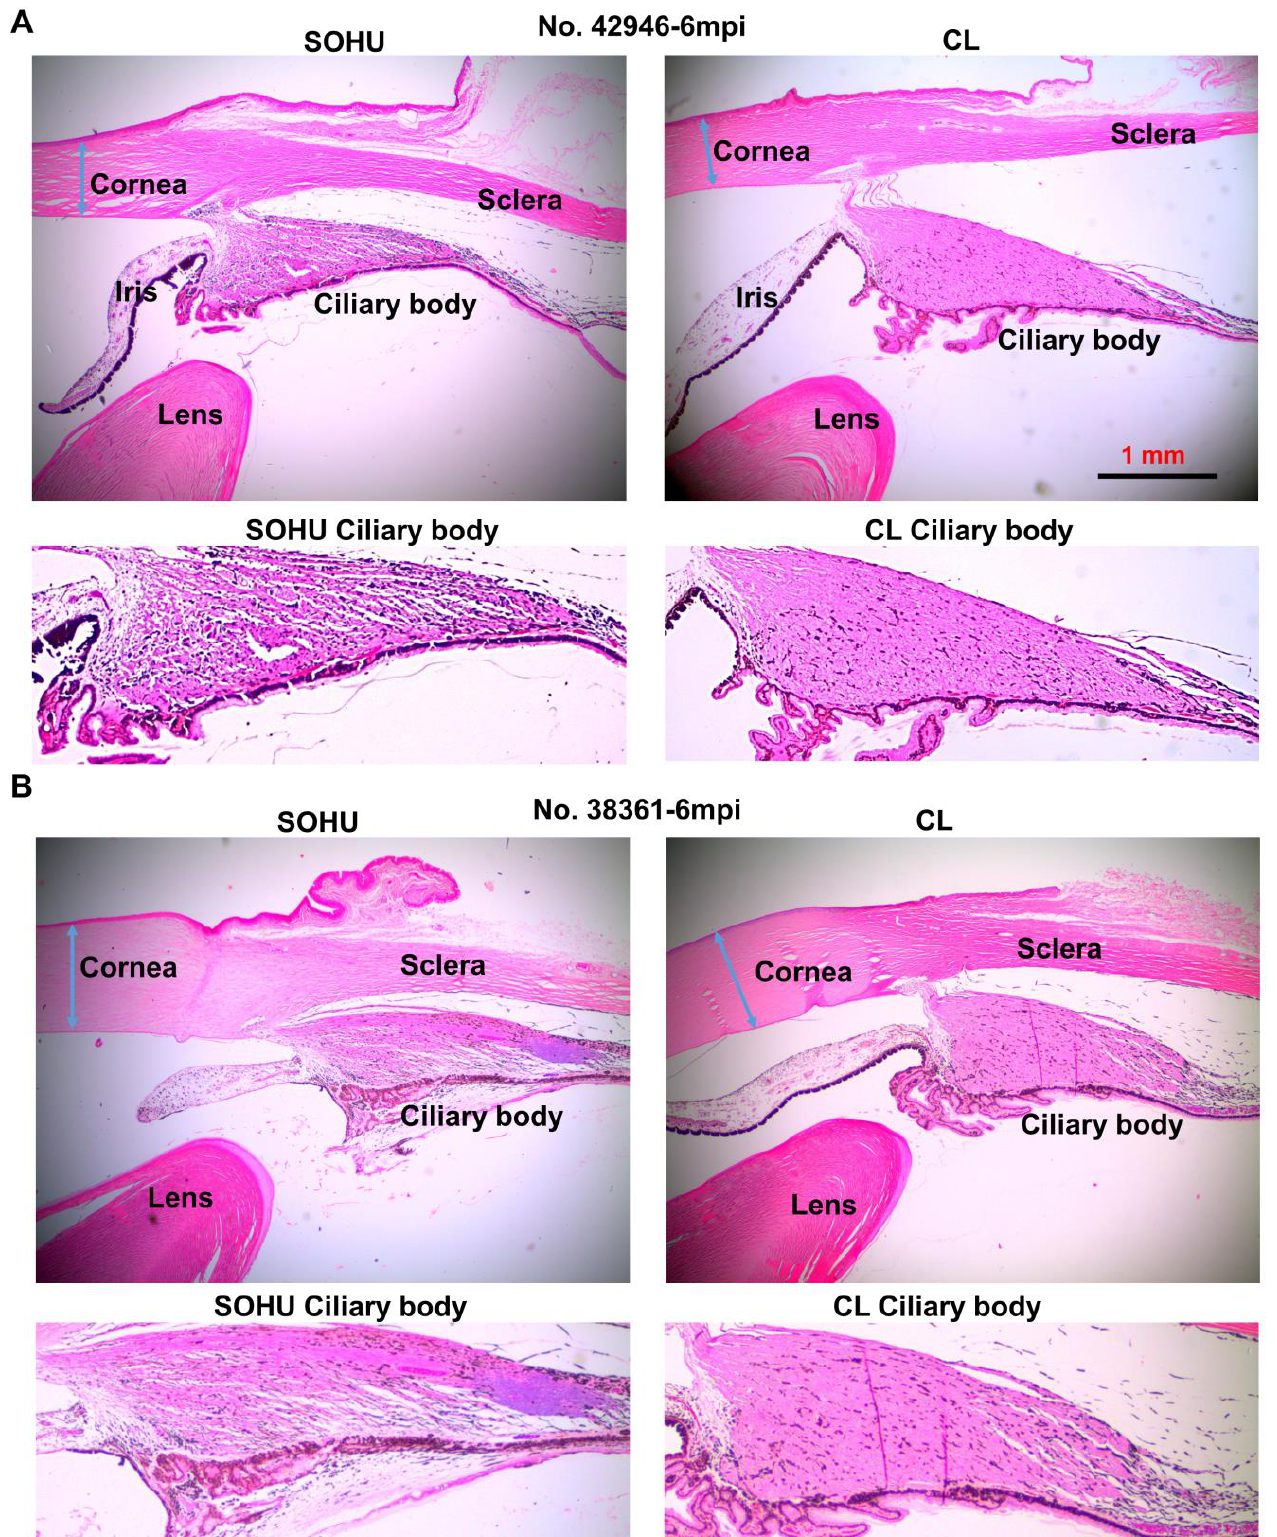
Figure 5. Ciliary body atrophy in SOHU eyes at 6 mpi. ( A ) Animal No. 42946; ( B ) Animal No. 38361. Anterior chamber sections stained with H & E and imaged with 2× lens; and enlarged images of ciliary body, showing loose arrangement, larger interfibrous areas, and increased cellular invasion in muscle fibers.